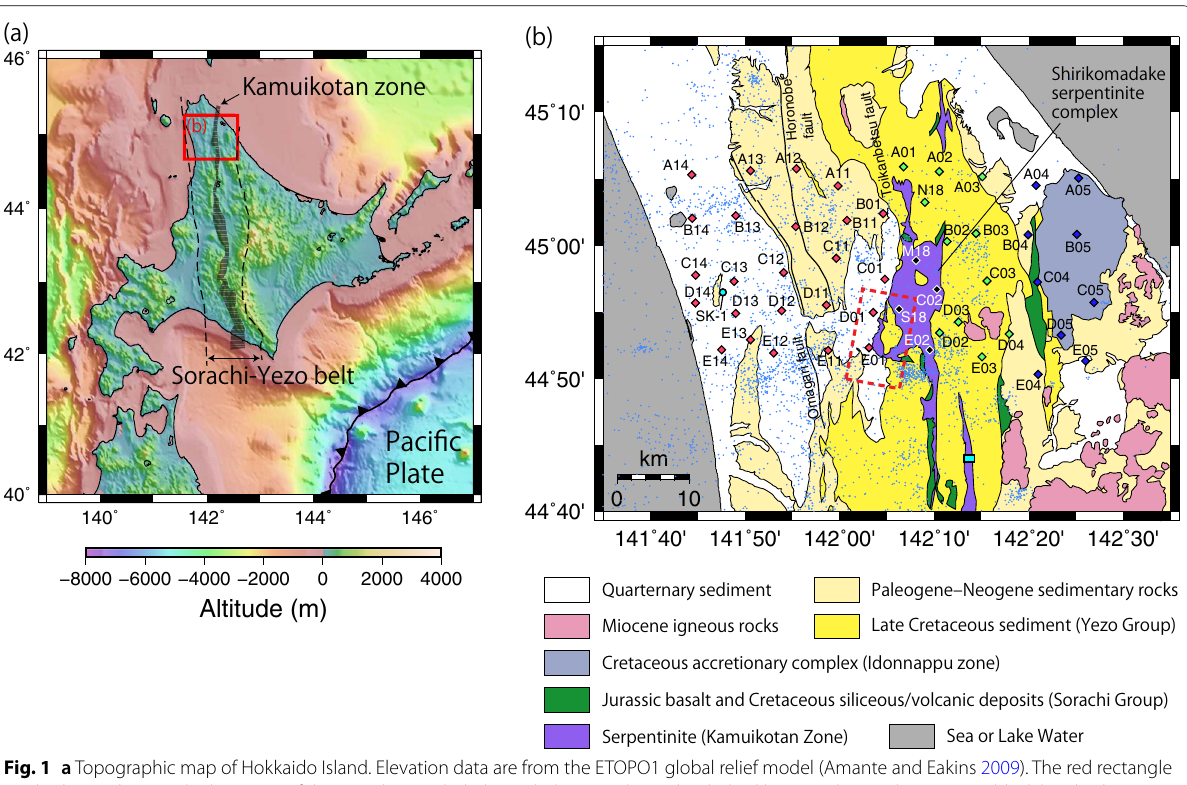
Fig. 1 a Topographic map of Hokkaido Island. Elevation data are from the ETOPO1 global relief model (Amante and Eakins 2009). The red rectangle marks the study area. The locations of the Sorachi-Yezo belt (bounded east and west by dashed lines) and Kamuikotan zone (black hatched area) are from Ueda (2016). b Geological map of the study area based on that compiled by the Japanese Institute of Advanced Industrial Science and Technology (AIST 2020). Solid black lines are active faults (Sakai and Matsuoka 2019). The light blue dots are hypocenters (M JMA > 0) compiled by the Japan Meteorological Agency (2019). Diamonds are MT recording sites; colors indicate the west to east zoning of the sites: red, western area; black (area of serpentinite outcrop) and green, central area; blue, eastern area. The cyan circle marks the borehole site of Ogura and Kamon (1992) and the cyan rectangle marks the location of the borehole and resistivity survey of Okazaki et al. (2011). The red dashed rectangle encloses the rupture zone of the SSE that occurred between July 2012 and January 2013 (Ohzono et al.